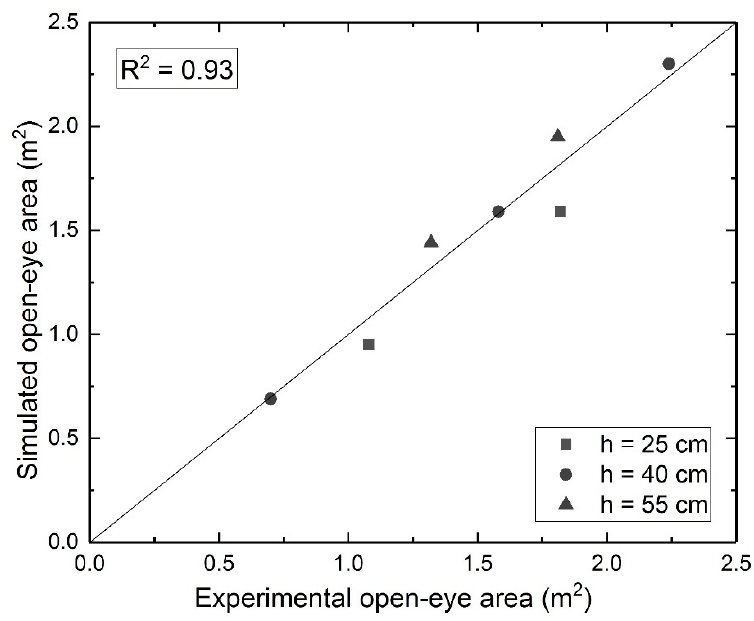
Figure 14. A comparison of experimental and simulated open-eye areas.